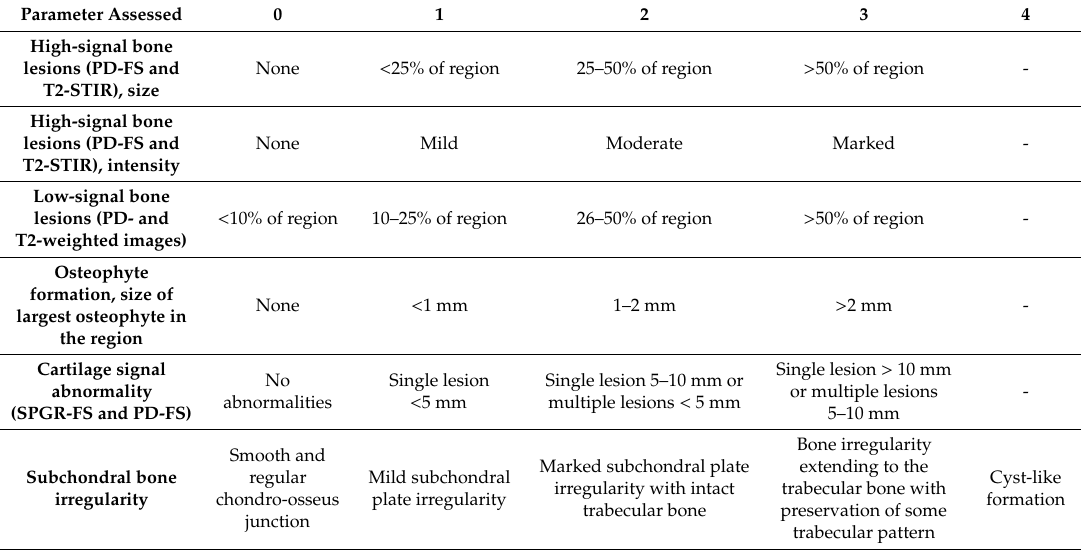
Table 3. Modified whole organ magnetic resonance score (WORMS) for the metacarpophalangeal / metatarsophalangeal joints.